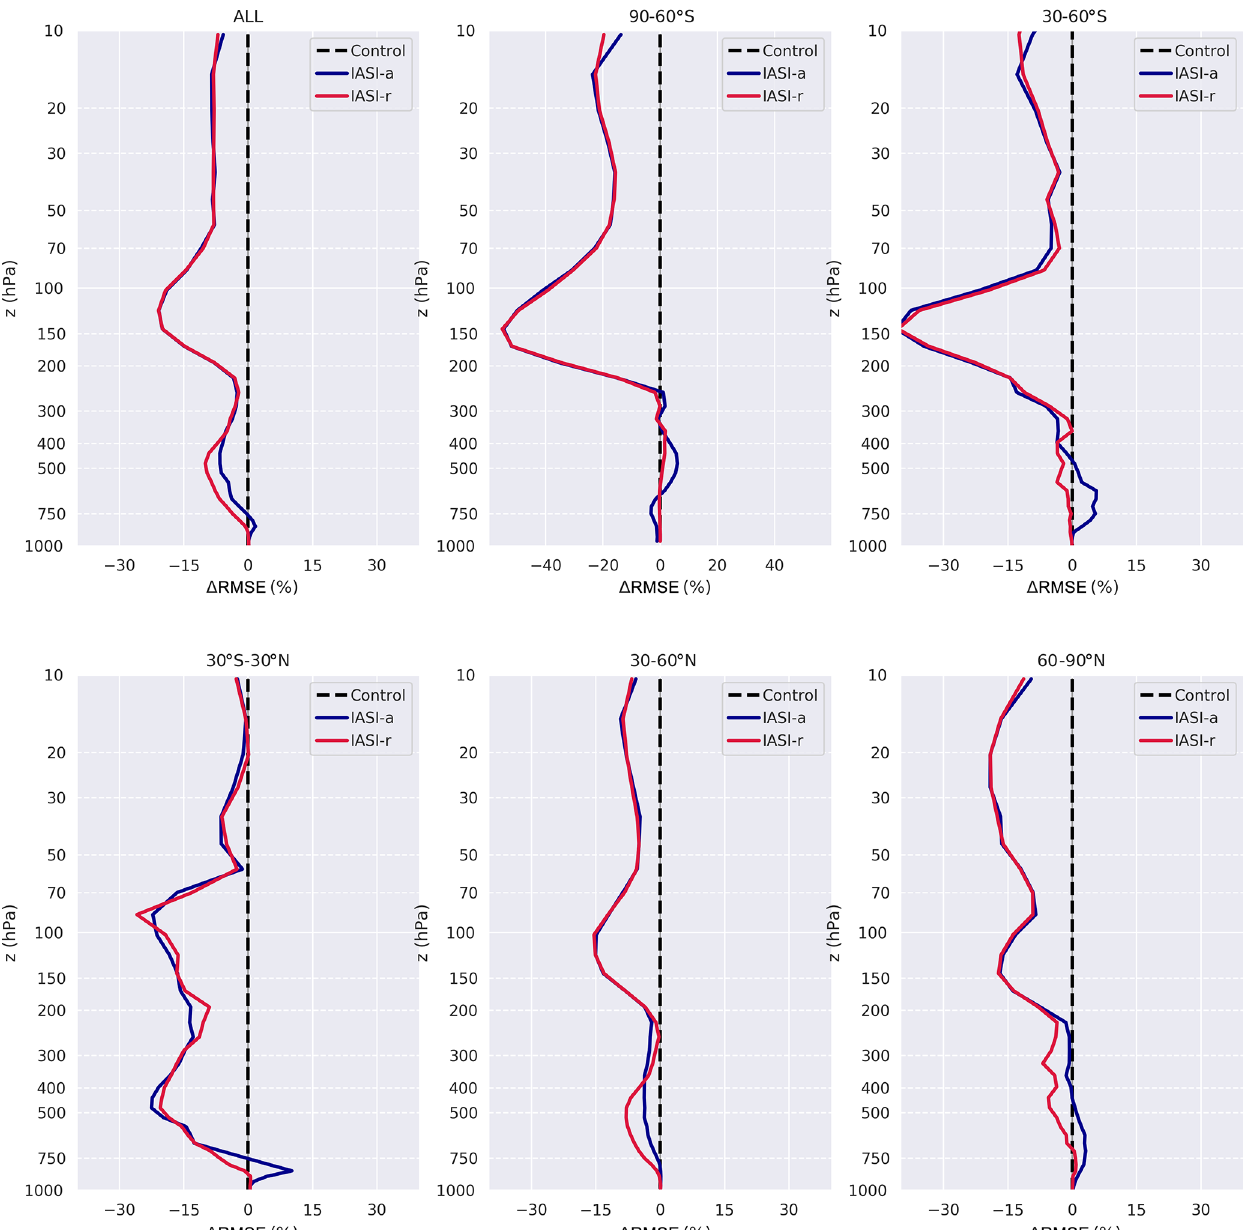
Figure 2. Relative gain in the root-mean-square error (RMSE) with respect to radio soundings averaged globally (top-left plot) and for five respective latitude bands: 90–60 ◦ S, 30–60 ◦ S, 30 ◦ S–30 ◦ N, 30–60 ◦ N, and 60–90 ◦ N (see panel headings). IASI-a is depicted in blue, and IASI-r is shown in red. Negative values indicate a decrease (improvement) in the RMSE with respect to the control simulation (dotted line), whereas positive values indicate an increase (degradation) in the RMSE with respect to the control